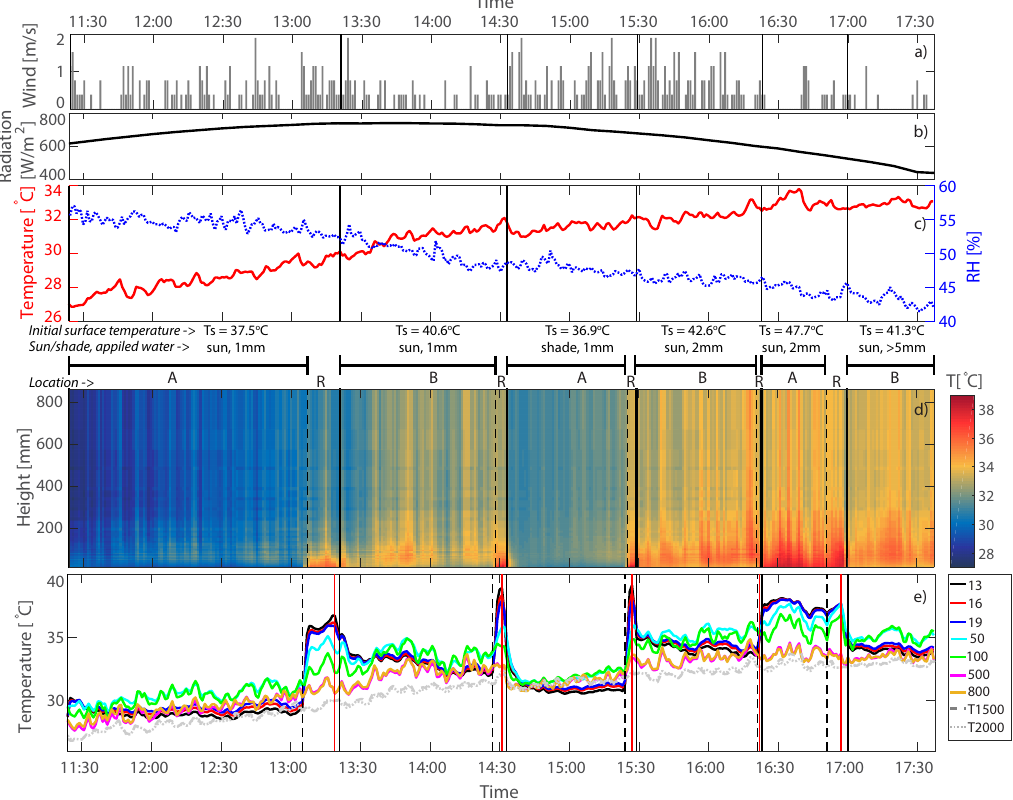
Figure 4. Measured ( a ) wind speed; ( b ) incoming radiation; and ( c ) temperature and relative humidity 2 m above the ground. Horizontal averages of temperatures over time for ( d ) all the layers in the setup; and ( e ) 9 chosen layers in the setup and 2 temperature sensors (T1500 and T2000 for 1.5 m and 2 m above the ground, respectively). The vertical, dashed lines show times when the setup was moved from its original location (A or B) to the reference location (R). The red vertical lines (only in ( e )) show times when the wetting of the surface started. The black vertical lines show the times when the setup was repositioned on the wet location. The weather station was always repositioned directly from Location A to B and vice versa at the times indicated by the black vertical